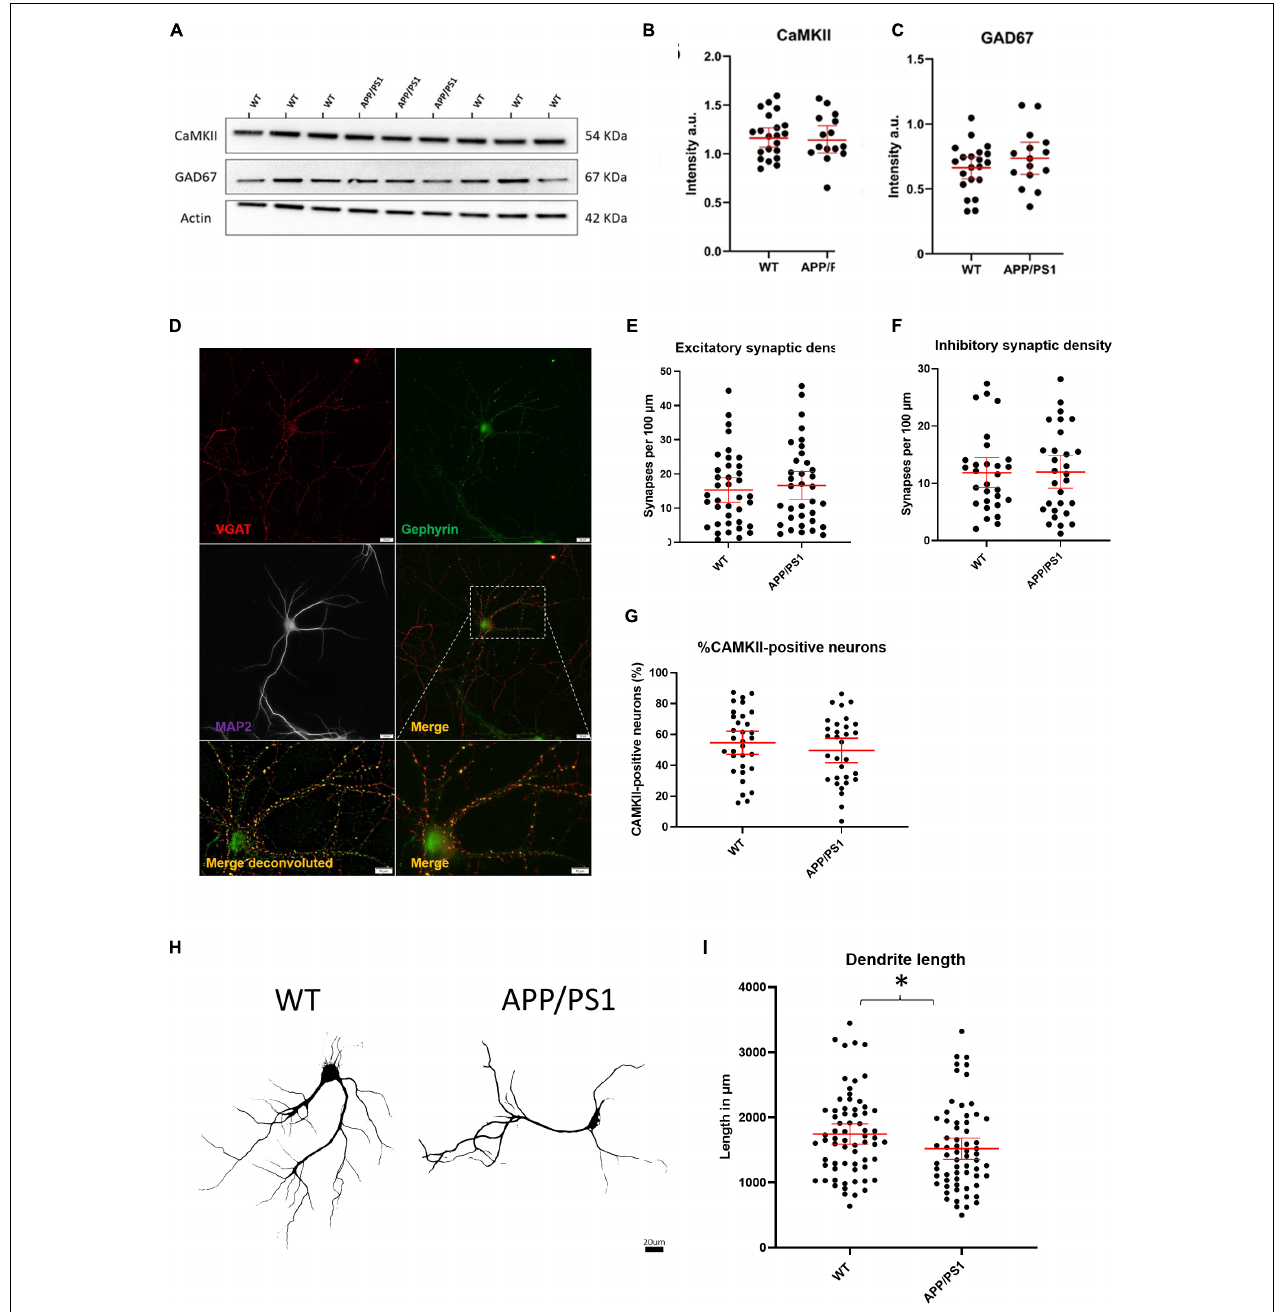
FIGURE 3 | No evidence for gross imbalances in excitatory/inhibitory neurons/synapses in APP/PS1 compared to WT neurons. (A) Representative western blot of CaMKII and GAD67 protein levels with actin as loading control. (B) Quantification of western blot of CaMKII in (A) (APP/PS1 mean = 1.164, CI = 1.030–1.298, n = 15 and WT mean = 1.181, CI = 1.080–1.282, n = 21, p = 0.8270). (C) Quantification of western blot of GAD67 in (A) (APP/PS1 mean = 0.7359, CI = 0.6129–0.8589, n = 15 and WT mean = 0.6620, CI = 0.5774–0.7466, n = 21, p = 0.2860, unpaired t -test). (D) Representative micrograph showing WT neuron labeled with VGAT (red), Gephyrin (green) and MAP2 (magenta). Lower panels show an enlarged view of neuron both with (left) and without (right) deconvolution. Scale bar = 20 µ m and for Merge, 10 µ m. (E) Graph depicting excitatory synaptic density from VGLUT/CAMKII overlap divided by neurite length (APP/PS1 mean = 16.64., CI = 12.53–20.74, n = 35 and WT mean = 15.28, CI = 11.74–18.83, n = 38, p = 0.6129, unpaired t -test). (F) Graph depicting inhibitory synaptic density from VGAT/Gephyrin overlap divided by neurite length (APP/PS1 mean = 12.00, CI = 9.160–14.84, n = 29 and WT mean = 11.87, CI = 9.243–14.50, n = 29 p = 0.9458). (G) Graph depicting quantification of percentage CaMKII neurons in WT and AD cultures. (APP/PS1 mean = 49.61% CaMKII positive neurons CI = 41.67–57.54% compared to WT mean = 54.64% CI = 47.08–62.14%, p = 0.35, unpaired t -test). (H) Representative binary images of WT and APP/PS1 neurons labeled for MAP2; scale bar = 20 µ m. (I) Graph showing decreased dendrite length in APP/PS1 compared to WT neurons (APP/PS1 mean = 1518, CI = 1355–1682, n = 64, and WT mean = 1744, CI = 1588–1900. N = 67, p = 0.045, unpaired t -test). * p < 0.05.